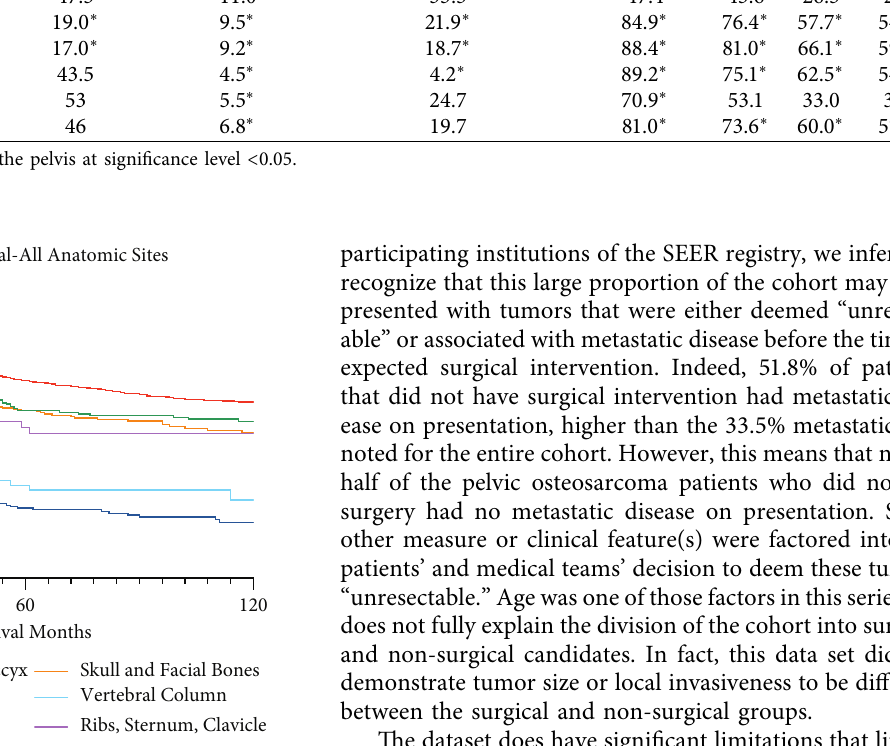
Figure 7: Kaplan–Meier survival curves for all osteosarcoma pa- tients by primary anatomic